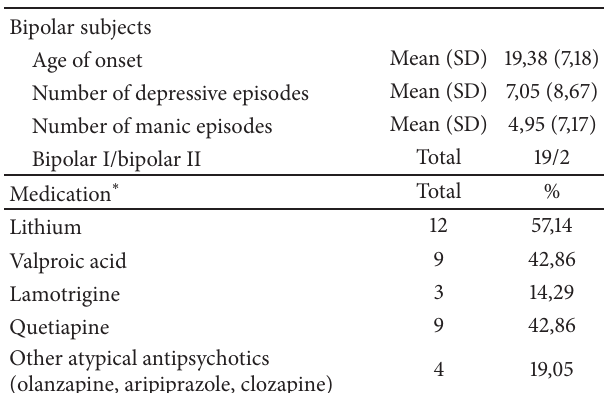
Table 2: Clinical variables.